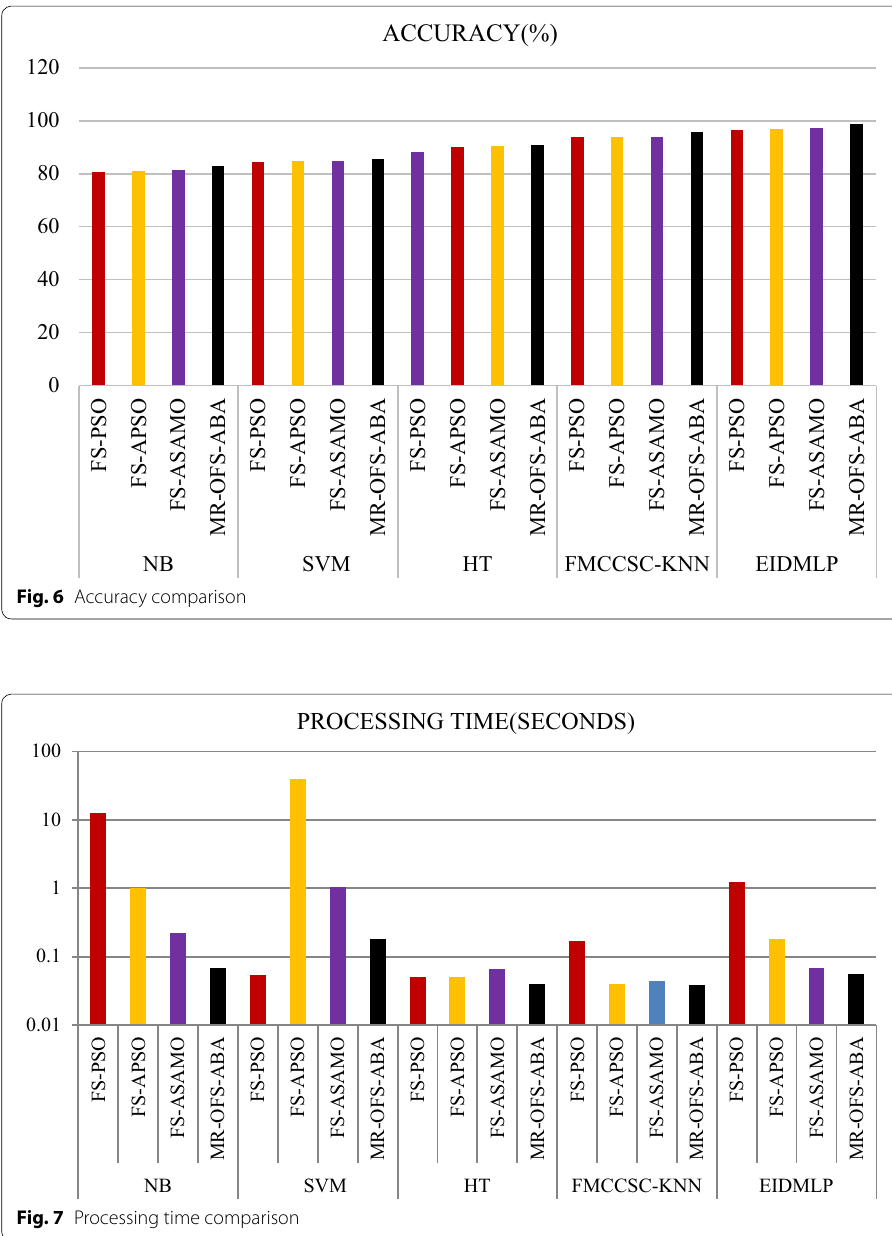
Fig. 7 Processing time